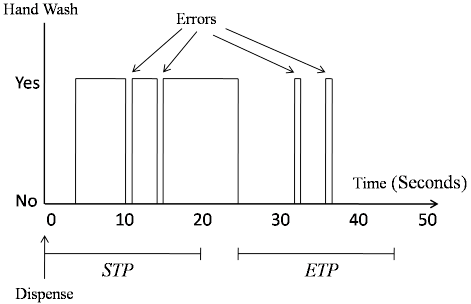
Figure 6: STP and ETP in a hand wash